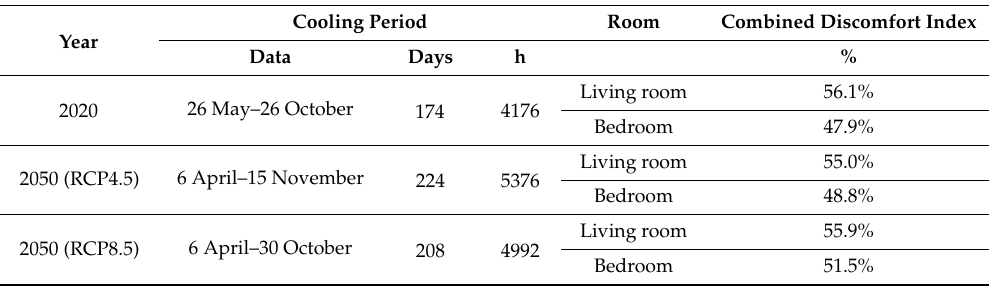
Table 7. Combined index assessment for the two analyzed rooms under di ff erent climatic scenarios: percentages over the relevant cooling